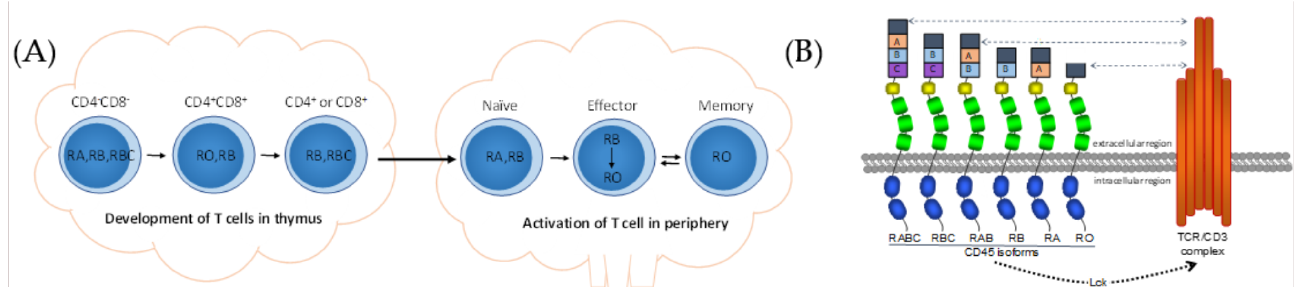
Figure 1. Expression and function of CD45 isoforms on T cells. ( A ) Expression of CD45 isoforms on the surface of T lymphocytes in thymus and peripheral lymphoid tissues. ( B ) Relationship of CD45 isoforms to the T cell receptor